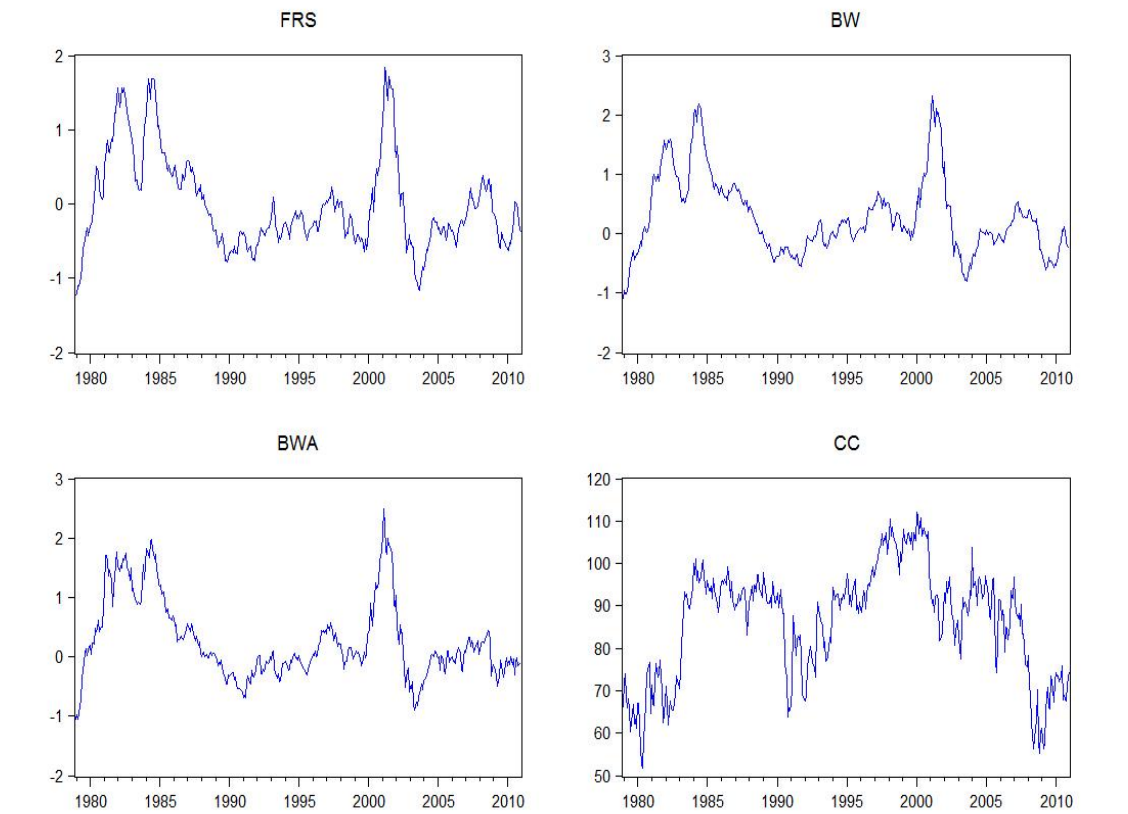
Figure 1. This figure shows time-series graphs of the paper’s modified BW index (FRS), BW, BWA, and CC. FRS is fundamental-removed-sentiment, BW is Baker and Wurgler’s [1] sentiment index, BWA is Baker and Wurgler’s [1] sentiment index that removes business cycle variation, and CC is the University of Michigan Consumer Sentiment Index. Sample is from July 1978–December